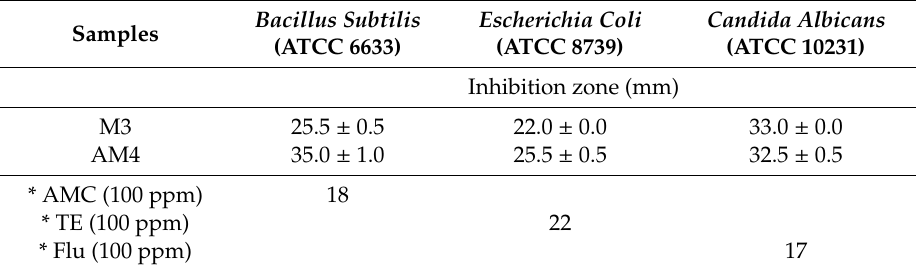
Table 2. The antimicrobial (anti-bacterial and anti-fungal) of the cross-linked terpolymer compounds (M3 and AM4). The result was described as the mean of the inhibition zones diameter (mm) with standard deviations